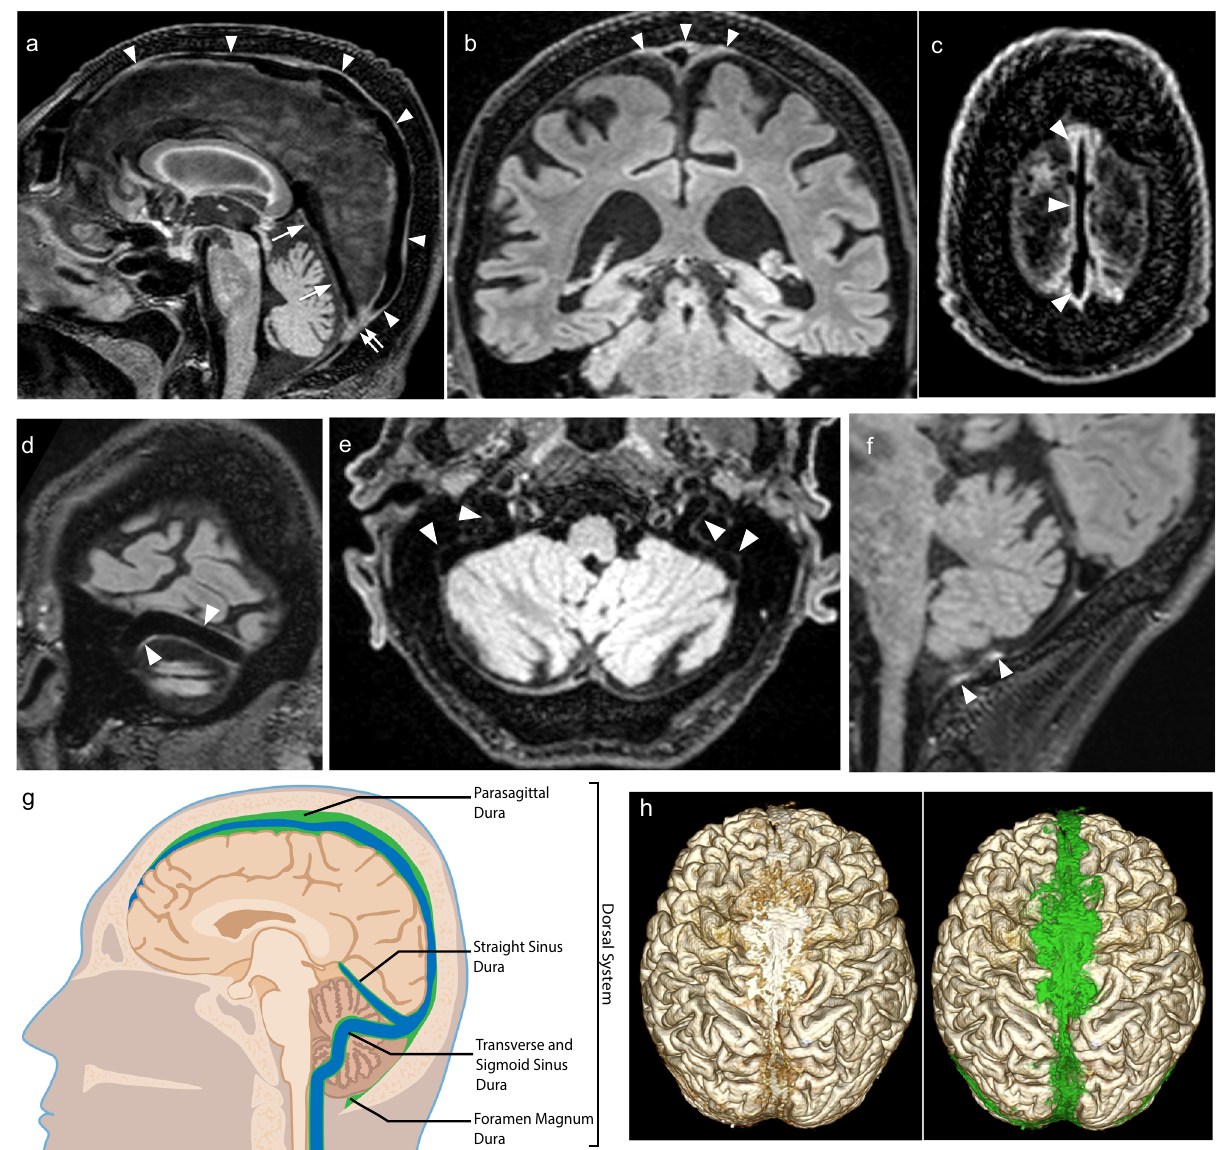
Fig. 3 Dorsal dural lymphatic system MR images and metrics from multiple subjects. a Sagittal FLAIR image shows linear signal increase representing the dural-parasagittal lymphatics around the walls of the superior sagittal sinus (arrowheads), straight sinus (arrows) and con fl uent sinus (double arrow). Coronal ( b ) and axial ( c ) FLAIR images depict thick dural-parasagittal lymphatic signals along the sagittal sinus (arrowheads) and the cortical veins. Similar but less prominent lymphatic signals are also seen along the wall, the transverse sinus ( d , arrowheads), sigmoid sinus, and jugular vein ( e , arrowheads). f Sagittal image depicts the dural lymphatic structures in the posterior aspect of the foramen magnum (arrowheads). g Illustration of distribution and relative volume of dorsal dural lymphatic structures (green) and venous system (blue) derived from T2-FLAIR h . 3D representation of dural lymphatics as de fi ned from T2-FLAIR shown from dorsal view. The dural lymphatics (bright parasagittal irregular structures) are de fi ned from T2-FLAIR and co-registered with rough segmentation of the brain and the dural-parasagittal lymphatics p = 0.001 and 484.6 cm 3 [SD 91] vs. 542.8 cm 3 [SD 109.3], sensitivity 50%, and speci fi city 76.3%) and ventral SI/thickness ratios (area under the curve 0.73, 95% CI 0.62 – 0.85, p < 0.001, p = 0.017, respectively), they had higher CSF volumes (252.5 cm 3 sensitivity 58%, and speci fi city 85.4%). In binary regression [83.9] vs. 136.1 cm 3 [SD 48.9], p < 0.001) compared with the analyses, an age older than 50 was associated with lower dorsal younger group. Older subjects had higher SI ratio and thickness and ventral SI/thickness ratios, independent of sex and total values in most aspects of the dorsal system, but lower SI ratio and intracranial volume (brain + CSF) measurement (OR 2.9, 95% CI higher thickness values in the ventral system compared with 1.1 – 7.7, p = 0.029 and OR 8.3, 95% CI 2.8 – 24.7, p < 0.001, younger ones (Fig. 6; Supplementary Table 6). The overall mean respectively). There were 29 subjects in the older group (>50 years SI ratio of the ventral system was signi fi cantly higher than that of old) and 52 subjects in the younger group. The older and younger the dorsal system in both younger (259.9 [SD 32.6] vs. 130.4 [SD age groups had similar sex ratios (females 55.2% and 55.8%, 23.6], p < 0.001) and older subjects (247.4 [SD 35.4] vs. 140.3 [SD respectively, p = 0.96). While the older group had lower GM and 21.1], p < 0.001) (Fig. 6a, b, d, e). The overall median thickness of WM volumes (647.9 cm 3 [SD 68.7] vs. 712 cm 3 [SD 98.1], the dorsal system was greater than that of the ventral system in